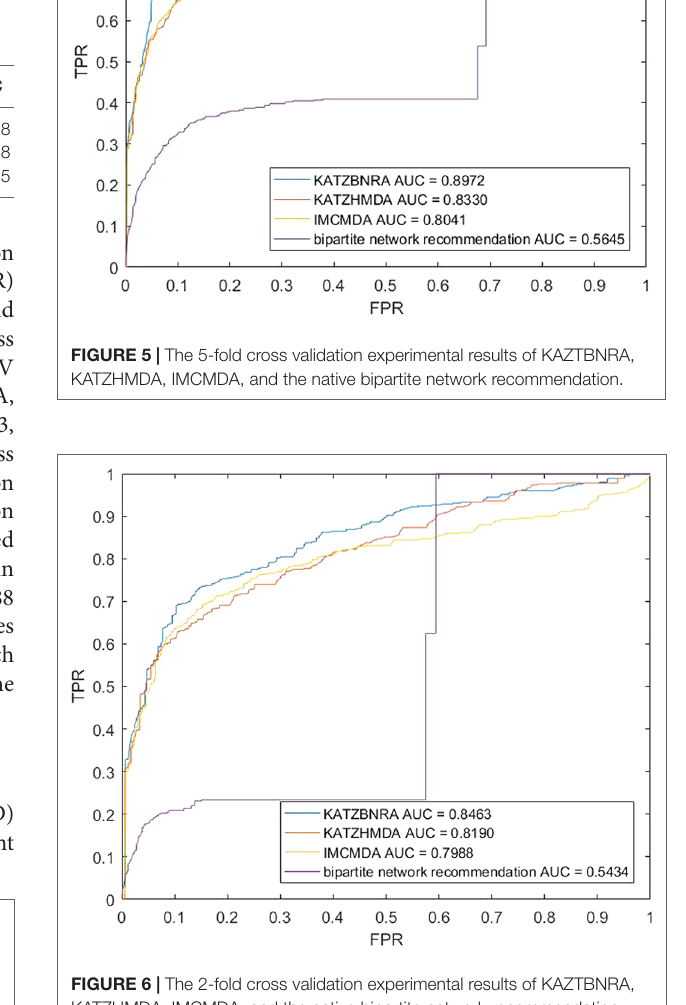
FIGURe 6 | The 2-fold cross validation experimental results of KAZTBNRA, KATZHMDA, IMCMDA, and the native bipartite network